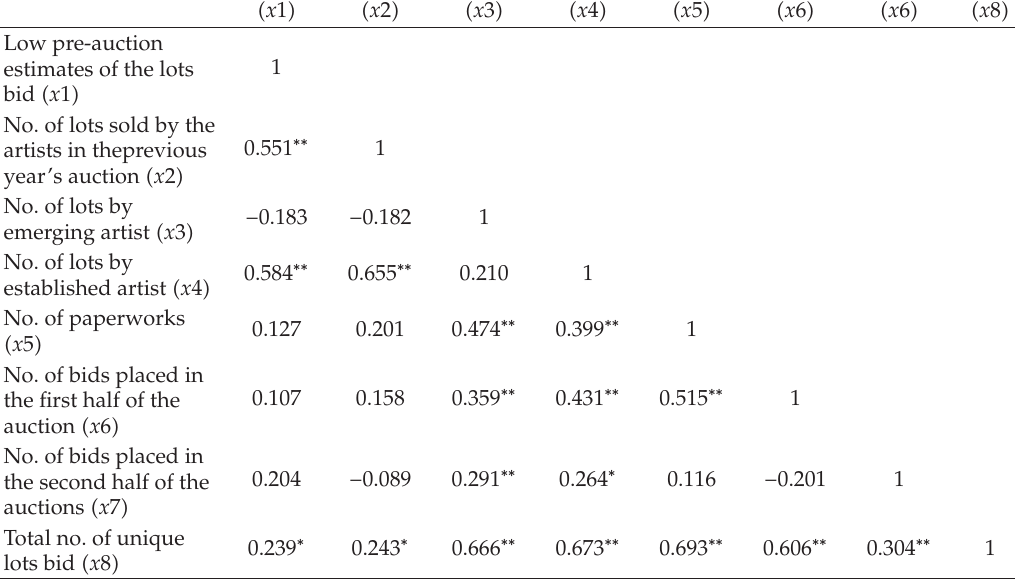
Table 2: Correlation matrix of the bidder